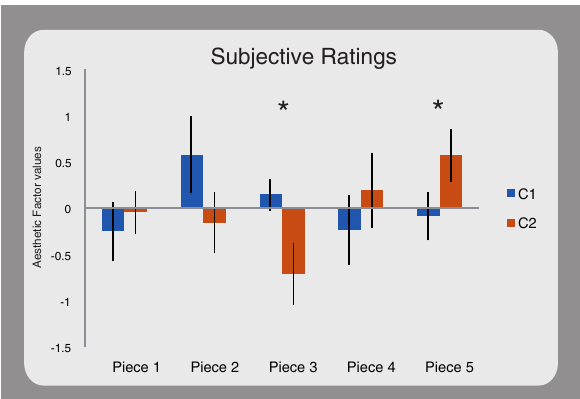
Figure 3. Subjective ratings. The histogram represents the Aesthetic factor (F1) modulation across pieces and conductors. Evaluations were performed by other musicians on the musical audio recordings. Bars show the standard error of the mean and asterisks denote significant differences.